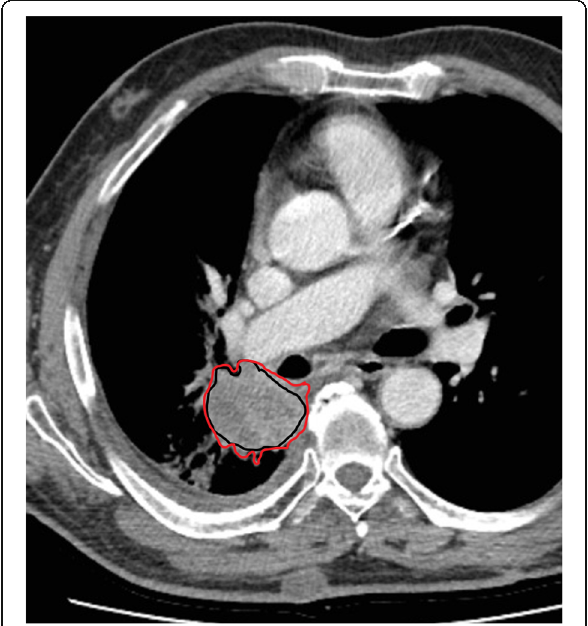
Fig. 4 An example of manual segmentation of lung cancer on computed tomography images. Although manual segmentation is often considered ground truth, this image shows red and black regions of interest delineated by two different readers for the same